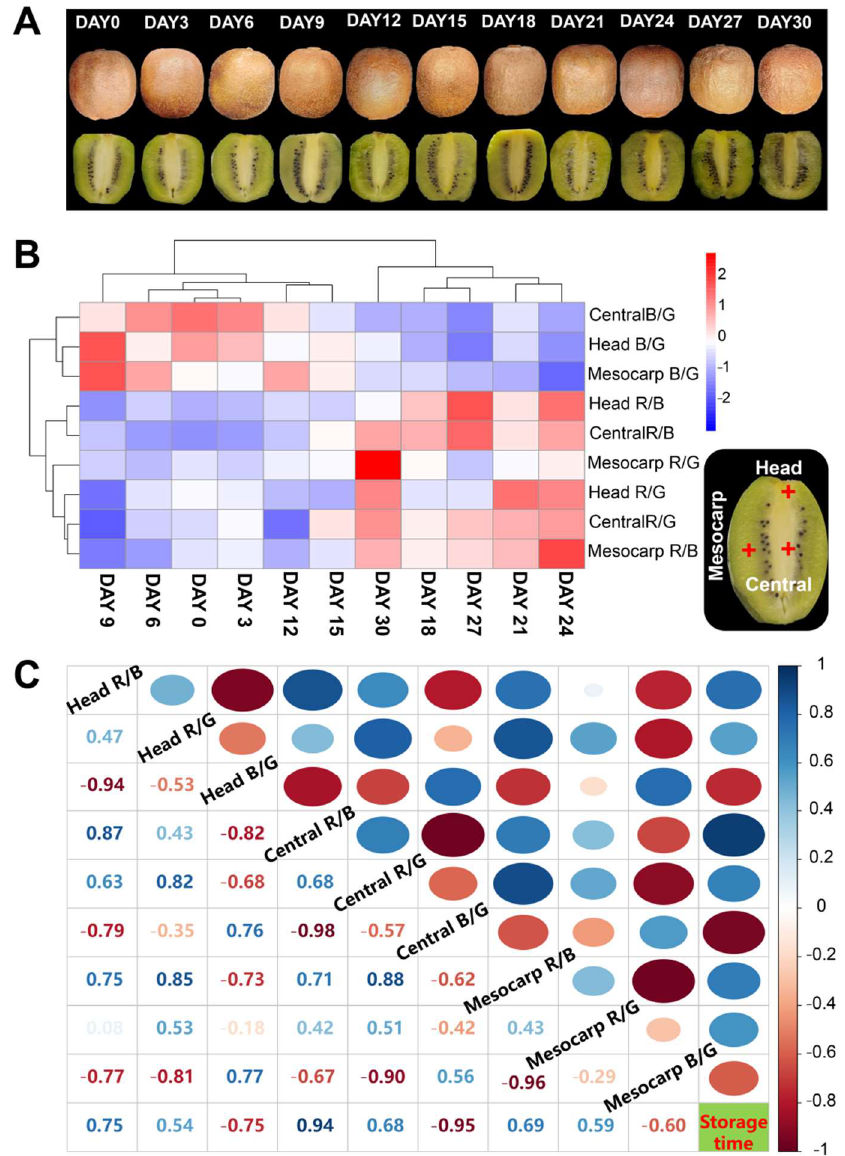
Figure 1. Appearance and flesh color of ‘Xuxiang’ kiwifruit changes during cold storage. Skin and longitudinal section of ‘Xuxiang’ kiwifruit stored at 2 °C for 1 month ( A ). Heatmaps of R/G, R/B and B/G values in different fruit sites ( B ). Correlation between R/G, R/B and B/G values in different fruit sites and storage times ( C ), where +1.0 and −1.0 represent stronger positive and negative correlations between the two features, respectively.